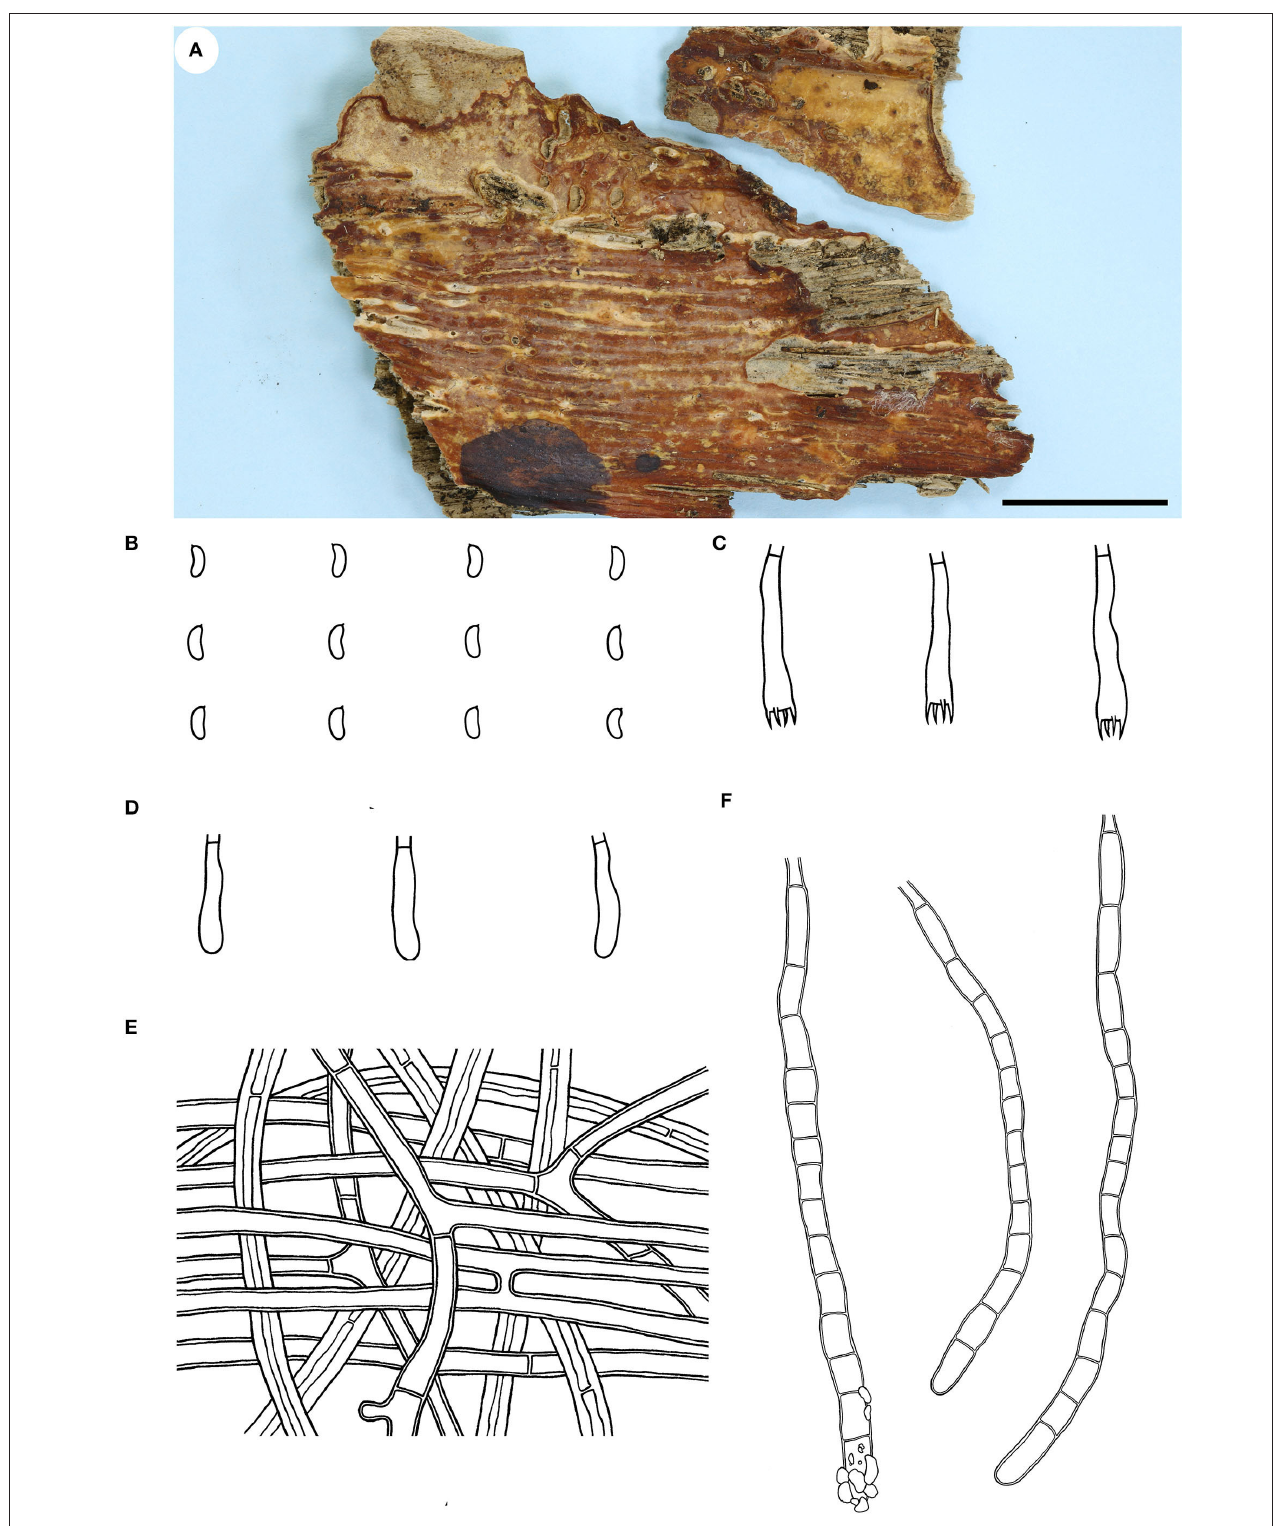
FIGURE 2 | Candelabrochaete guangdongensis (from the holotype He 5902; scale bars: a = 1cm; b–d, f = 10 µ m; e = 20 µ m). (A) Basidiomata. (B) Basidiospores. (C) Basidia. (D) Basidioles. (E) Septocystidia. (F) Hyphae from subiculum.